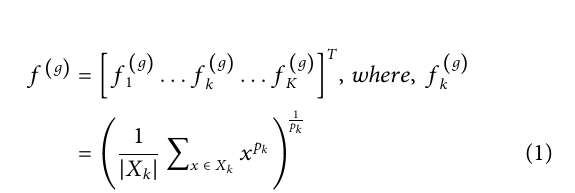
FIGURE 4 | The detailed 3D CNN network. The four MRI modalities are integrated as the network input. All images are cropped to a fi xed size of 128 × 192 × 192 pixels. The backbone adopts the 3D ResNet, followed by a global average pooling and a fully connected layer to classify the brain